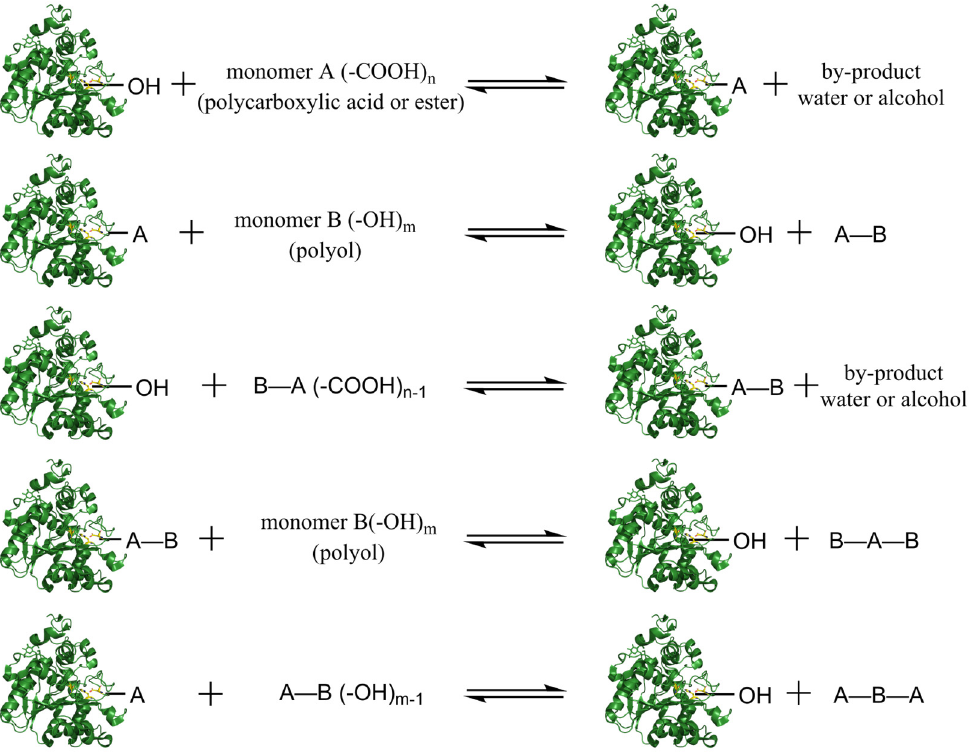
Figure 7. Enzyme-catalyzed polycondensation in the presence of Lipase. monomer A represents polycarboxylic acid or ester formed with alcohol, “n” represents the number of carboxylic acid groups in monomer A. monomer B represents polyol, “m” represents the number of hydroxyl groups in monomer B (m ≥ 2, n ≥ 2). Structures of lipases were rendered using PyMOL [80]. The copyright detail is shown in supplementary material.